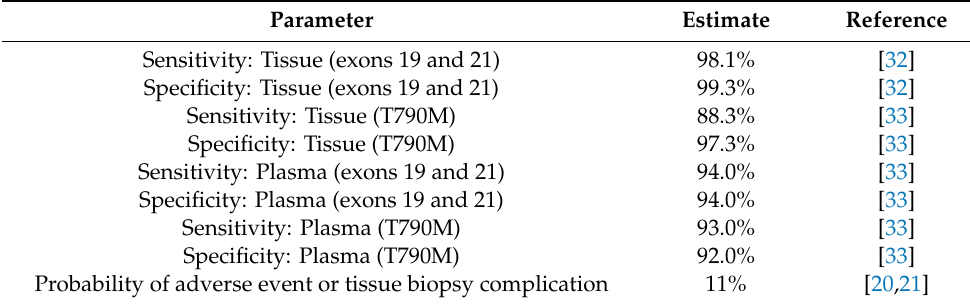
Table 2. Clinical inputs used in the base-case analysis.